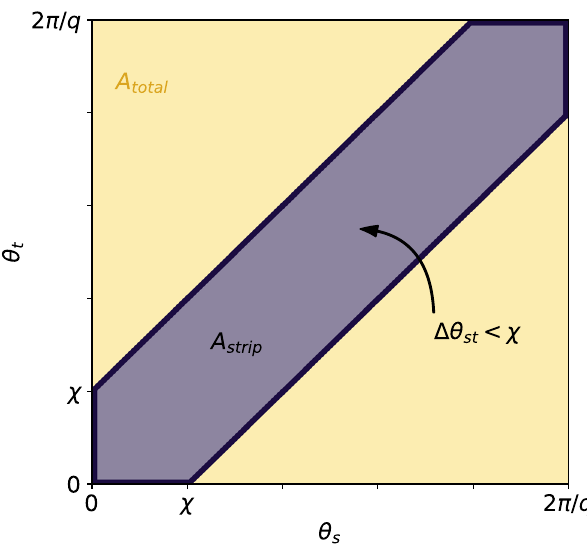
Fig. 6 Graphical solution for calculating the distribution of the angular distance between nodes inside a given circular sector. The yellow region represents all possible values of the angular coordinates θ s , θ t of two arbitrary nodes s , t conditioned on that they fall into the same angular sector with a central angle 2 π / q . The grey strip shows those combinations of θ s and θ t values, where Δ θ st is smaller than a given value of χ